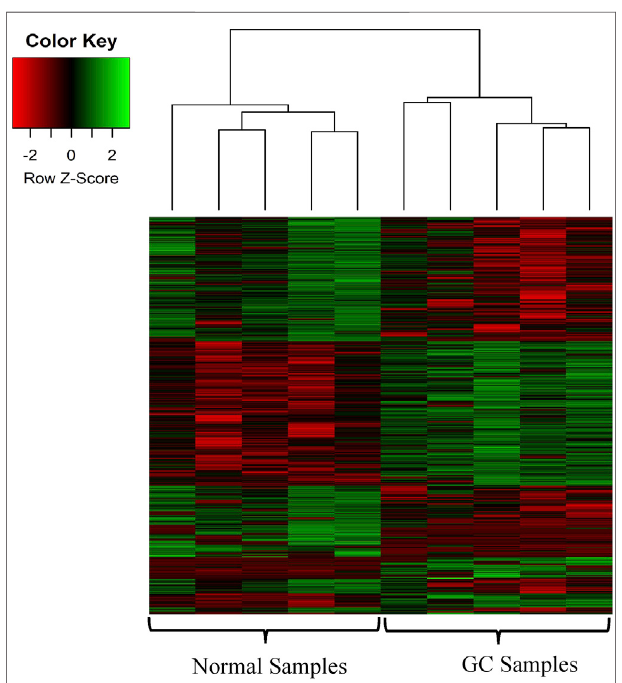
FIGURE 4 | Heatmap of the DE circRNAs. The heatmap represents the expression pro fi le of the DEcircRNAs in GC compared tothe adjacentnormal tissues.ThecolorscaleindicatestheLog2FoldChangeoftheexpressionvalue for each circRNA in cancers vs normal tissues. Red and green colors indicate down-regulation and up-regulation of the circRNAs respectively.